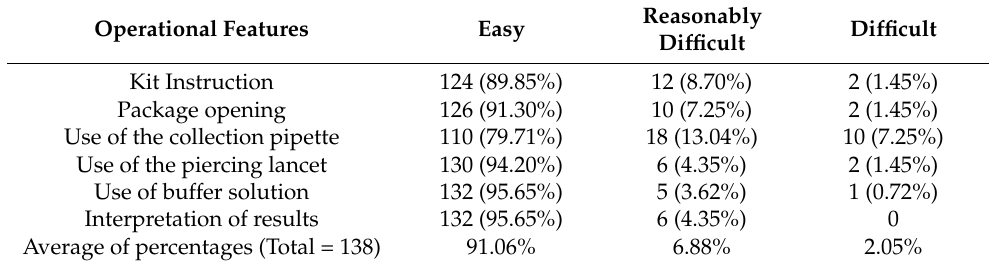
Table 5. Operational feasibility of the HIV-Syphilis rapid diagnostic test among healthcare